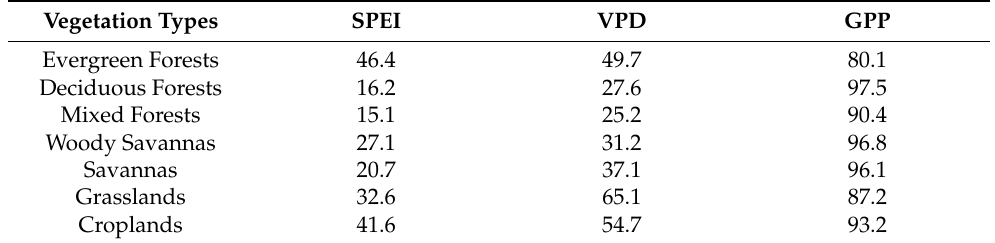
Table 2. The area proportions of the annual decreasing trend of SPEI, increasing trend of VPD, and increasing trend of GPP from 2001 to 2020 across China, under different vegetation types (unit: %). Vegetation Types SPEI VPD GPP Evergreen Forests 46.4 49.7 80.1 Deciduous Forests 16.2 27.6 Mixed Forests 15.1 Woody